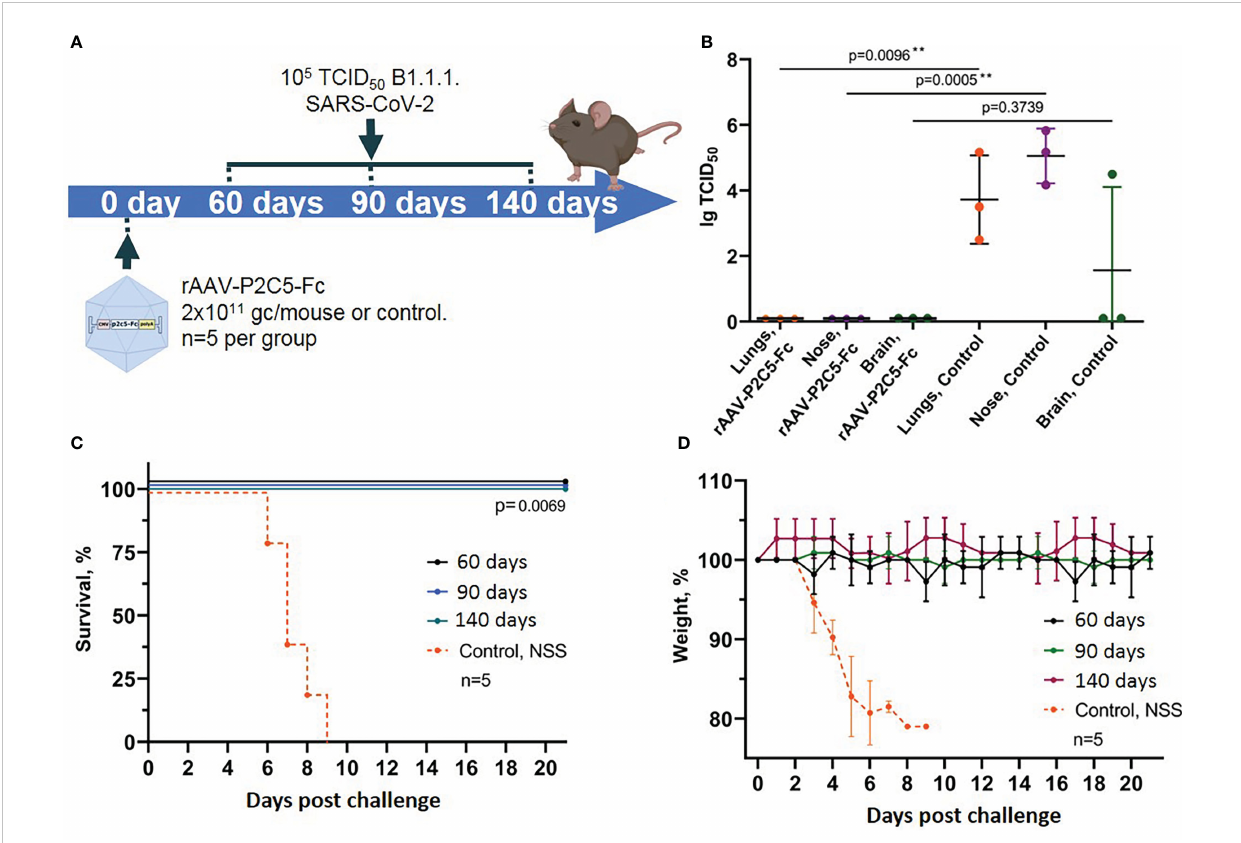
FIGURE 5 Evaluation of long-term protective activity of rAAV-P2C5-Fc against SARS-CoV-2. (A) Scheme of the experiment: mice were treated with rAAV- P2C5-Fc at a dose of 2*10 11 gc/animal on days 60, 90, 140 before the challenge with SARS-CoV-2 B.1.1.1 variant at a dose of 10 5 TCID50. (B) Viral load in the organs of animals infected with SARS-CoV-2 on day 140 after the treatment. (C) Animal survival. (D) Body weight loss. Lines – mean values, error bars – SD, numbers indicate statistical signi fi cance evaluated compared with the vehicle group using a logrank test (survival) or Mann – Whitney U test (viral load). Data from different treatment groups are shown by color. Control, NSS – mice received normal saline solution. n – number of animals per group. ** means statistically signi fi